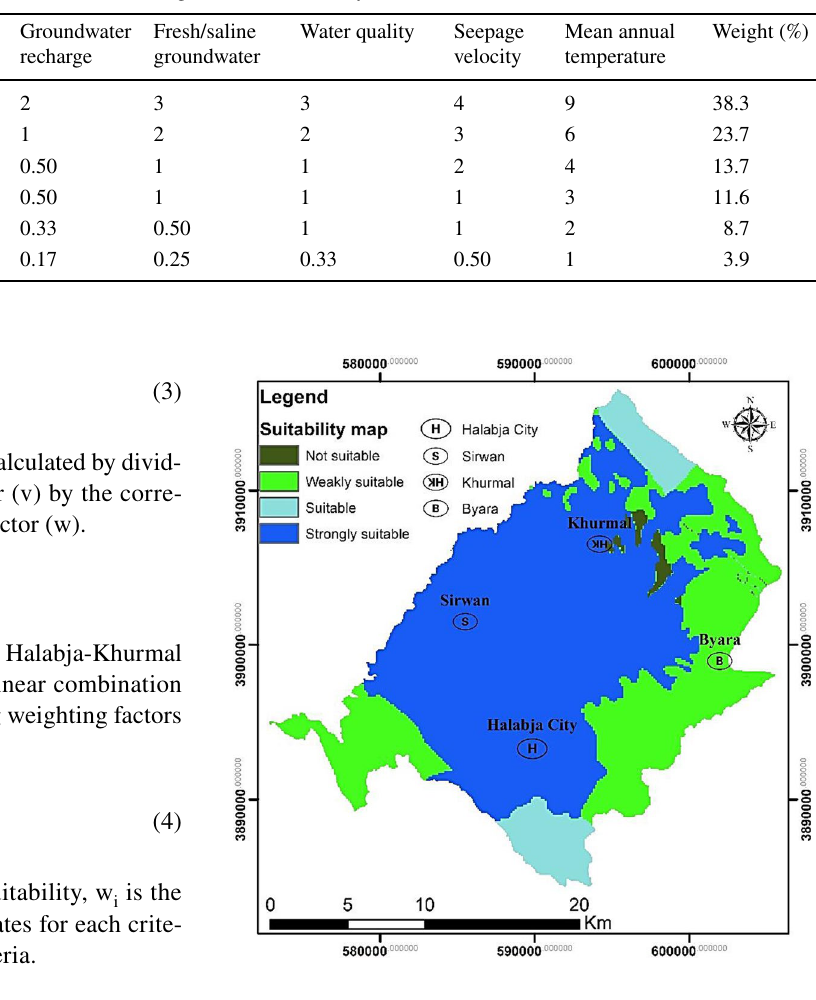
Fig. 4 The ATES suitability